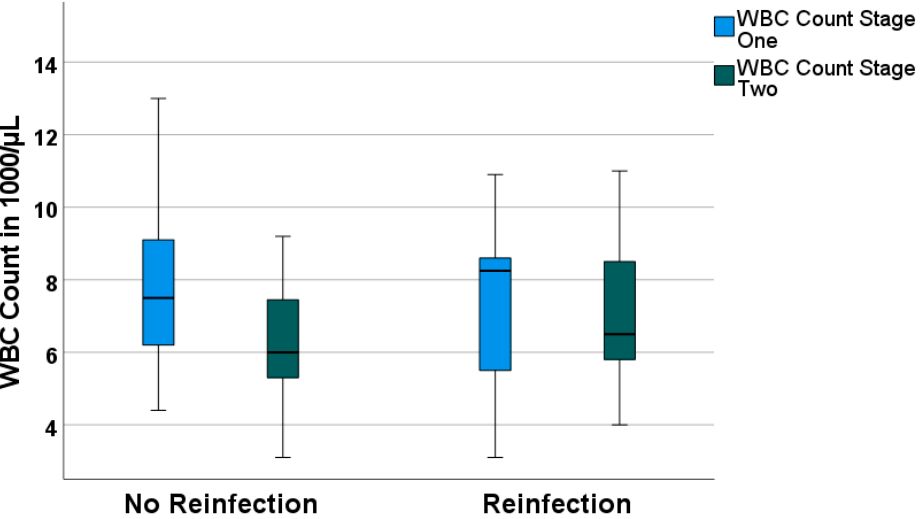
Figure 2. Boxplots for white blood cell count (WBC count) values of the first stage of TSR and the second stage of TSR, grouped according to “no reinfection” and “reinfection”.